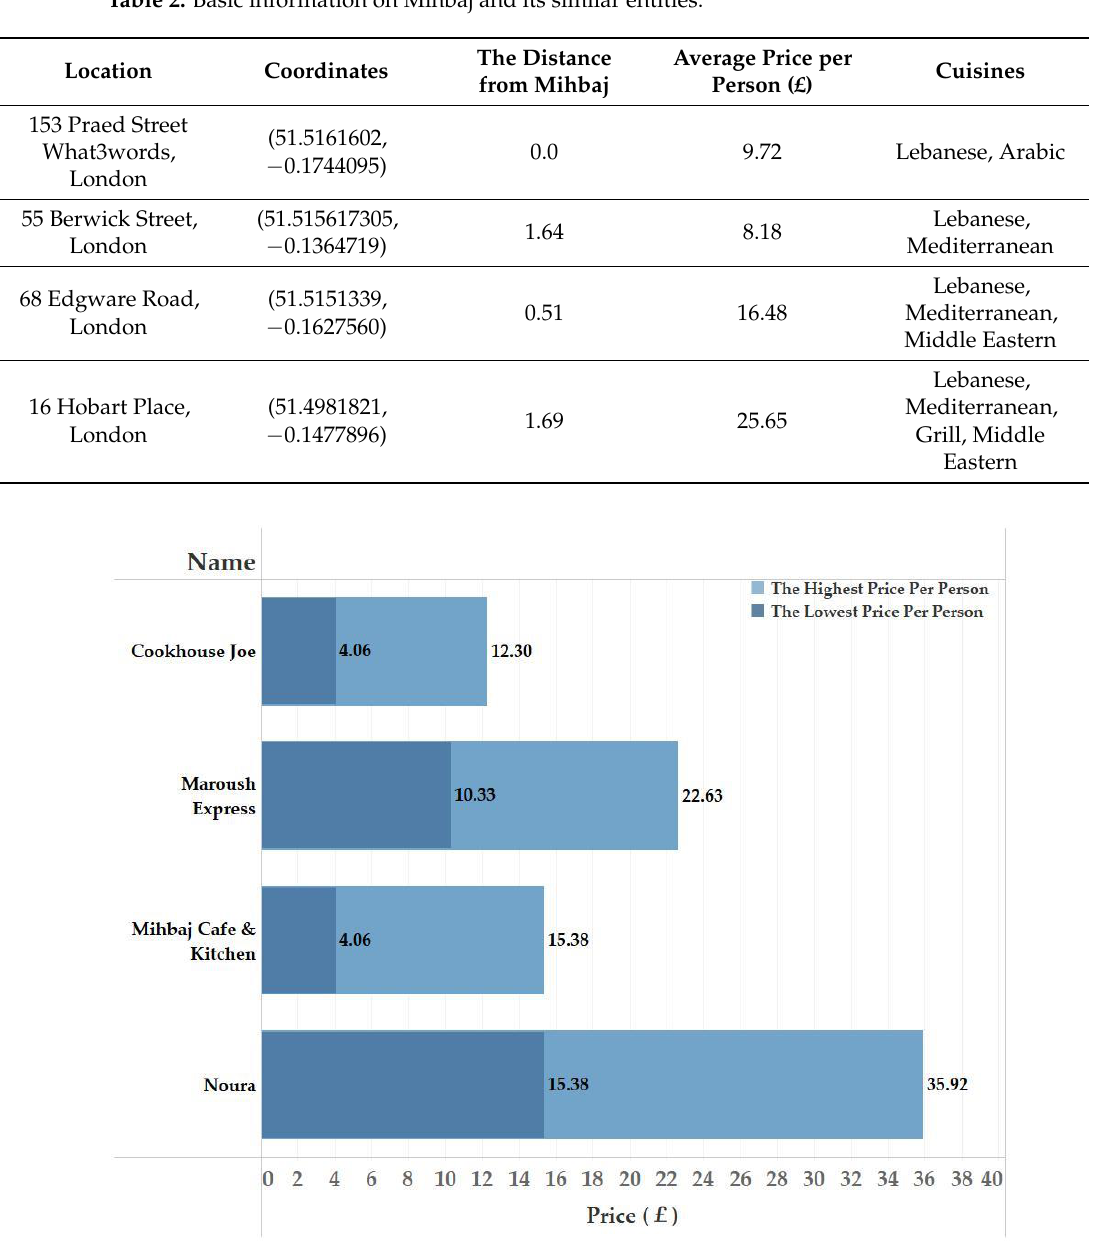
Table 2. Basic information on Mihbaj and its similar entities.